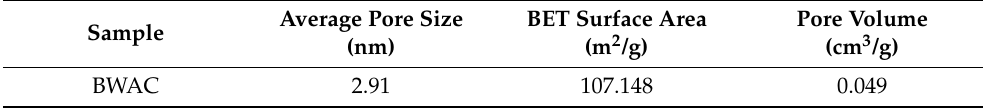
Figure 3. N 2 adsorption–desorption isotherms of BWAC. Table 2. BET textural data of BWAC.